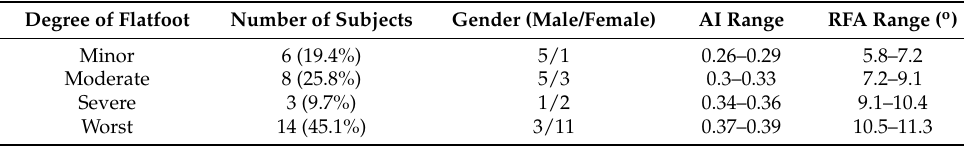
Table 2. Degree of flatfoot according to Equation (2).